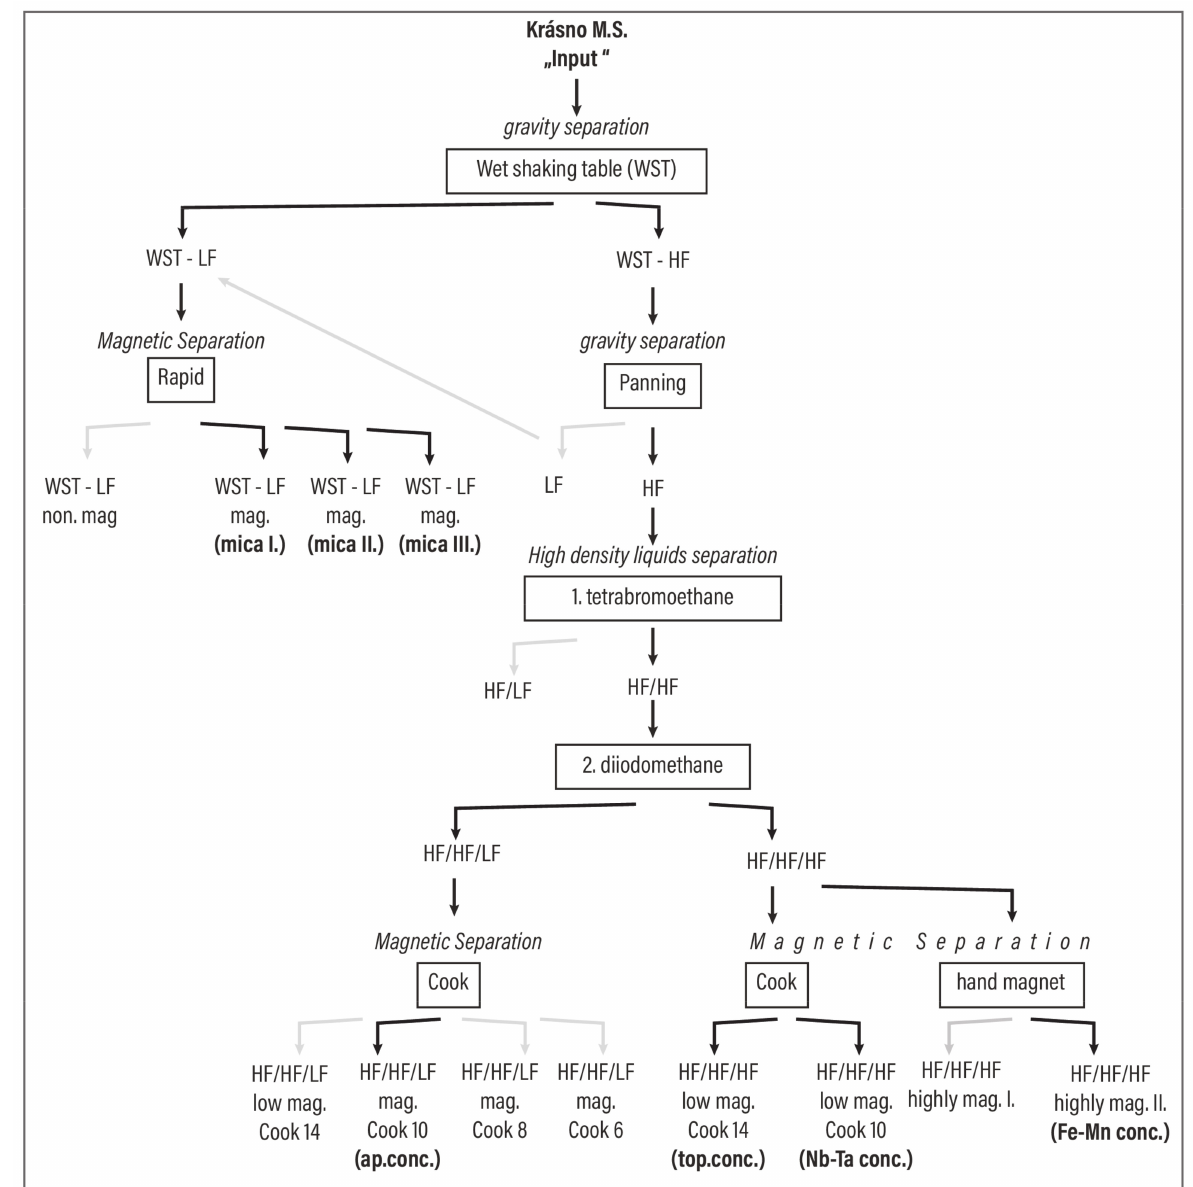
Figure 3. Flow-chart of laboratory separation procedure applied in the current study. The most important products of separation procedure, investigated in this study, are shown in